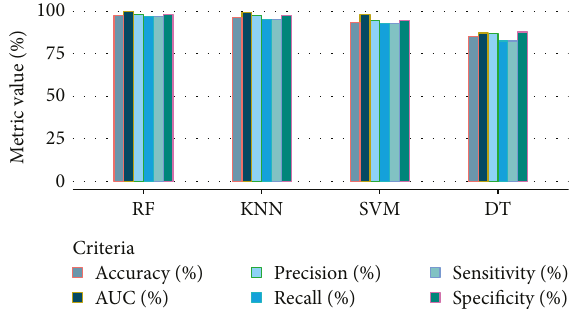
Figure 8: Performance of di ff erent classi fi cation models for FSW dataset.